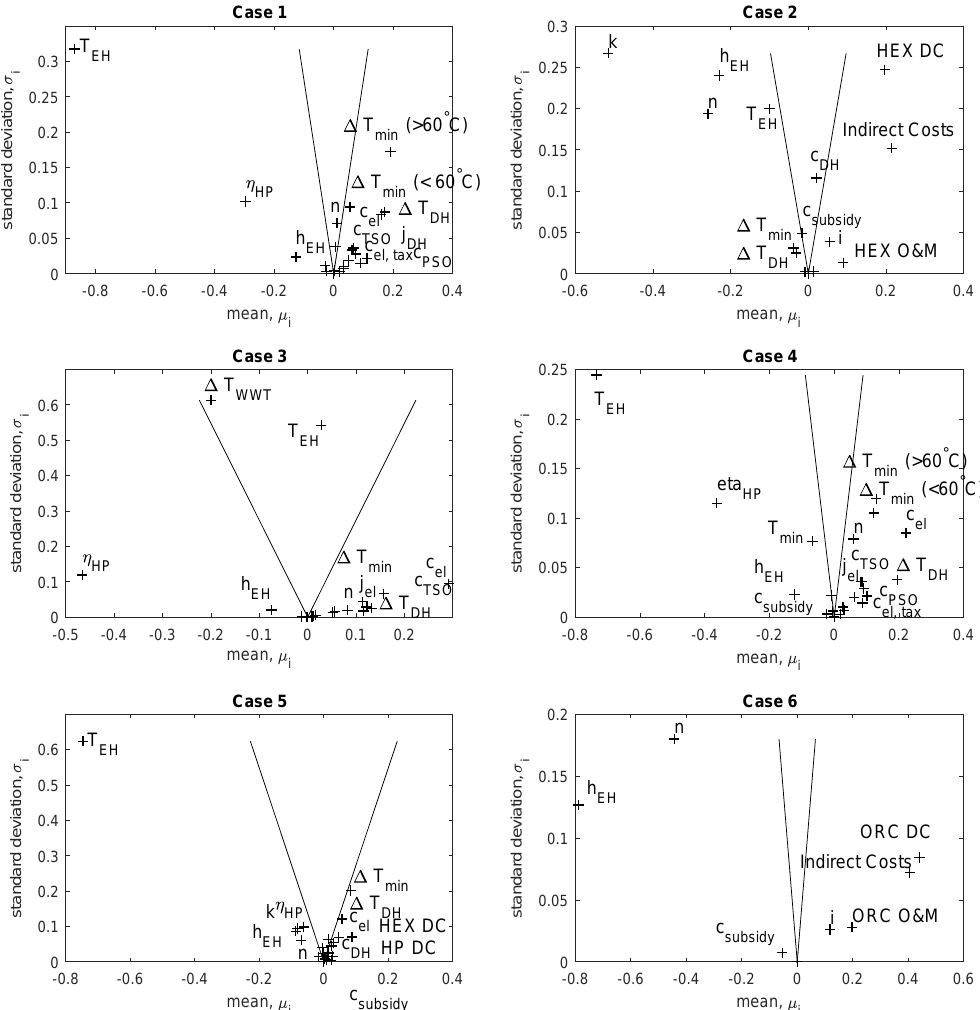
Figure 7. Results of the Morris screening for the most important parameters influencing the costs of supplied energy ( c H